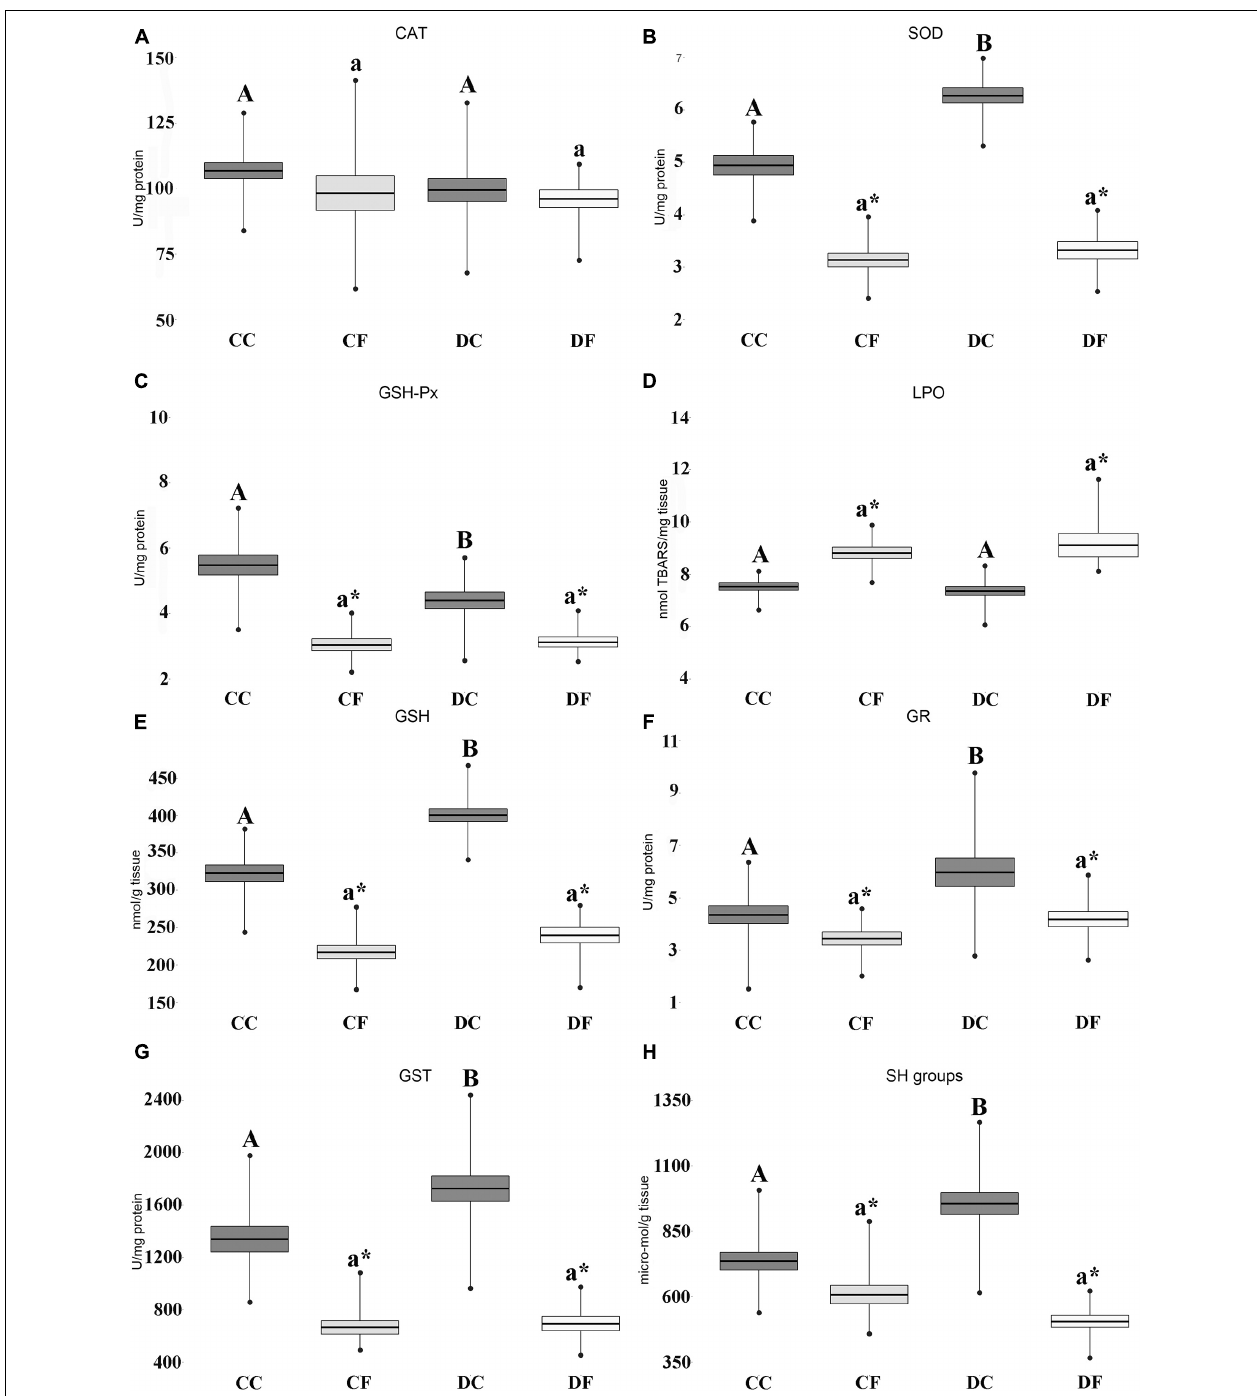
FIGURE 2 | Effects of 2-weeks of fasting/feeding treatment on oxidative stress parameters of the yellow belly toad ( Bombina variegata ) juveniles that developed under constant and decreasing water levels. CC, Feeding individuals that developed under constant water availability; CF, Fasting individuals that developed under constant water availability; DC, Feeding individuals that developed under exposure to the desiccation regime; DF, Fasting individuals that developed under the desiccation regime. (A) Catalase; (B) superoxide dismutase; (C) glutathione peroxidase; (D) lipid peroxidation; (E) glutathione; (F) glutathione reductase; (G) glutathione-S transferase; (H) SH groups. “*” indicates significant differences between fasting and feeding treatments under the same water regime; capital letters “A” and “B” indicate differences between feeding individuals exposed to desiccation and constant water availability; lower case letters “a” and “b” indicate differences between fasting individuals exposed to desiccation and constant water. Different letters indicate significant differences ( P ≤ 0.05). Line, Mean value; box, Standard error; bars, Minimal and maximal value.